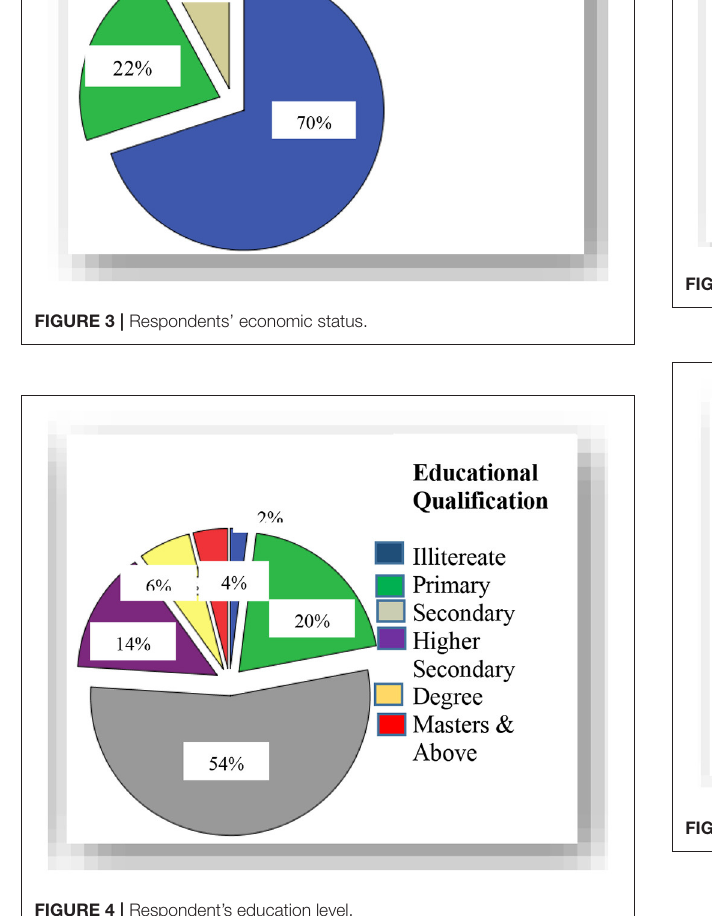
FIGURE 4 | Respondent’s education level.